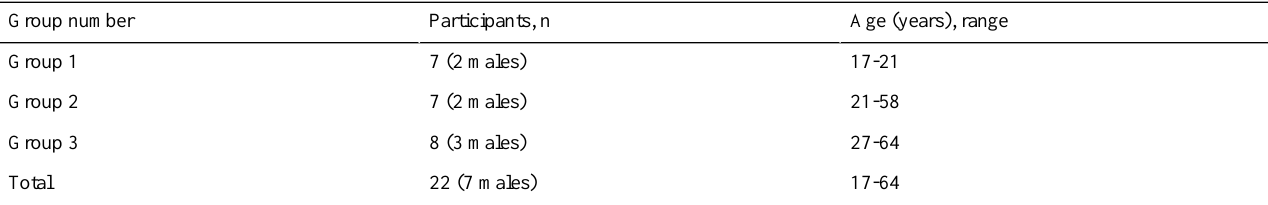
Table 2. Participants in co-design